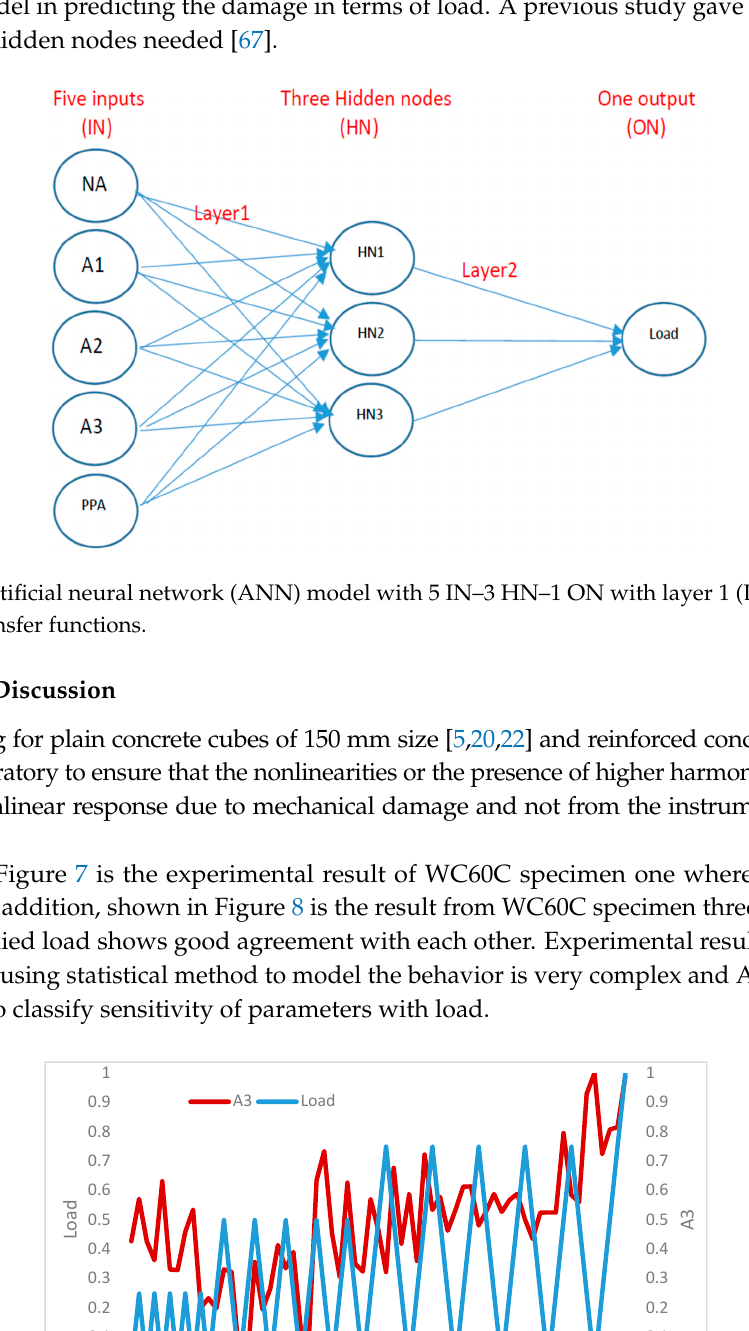
Figure 7. WC60C Specimen one: A3 versus load.